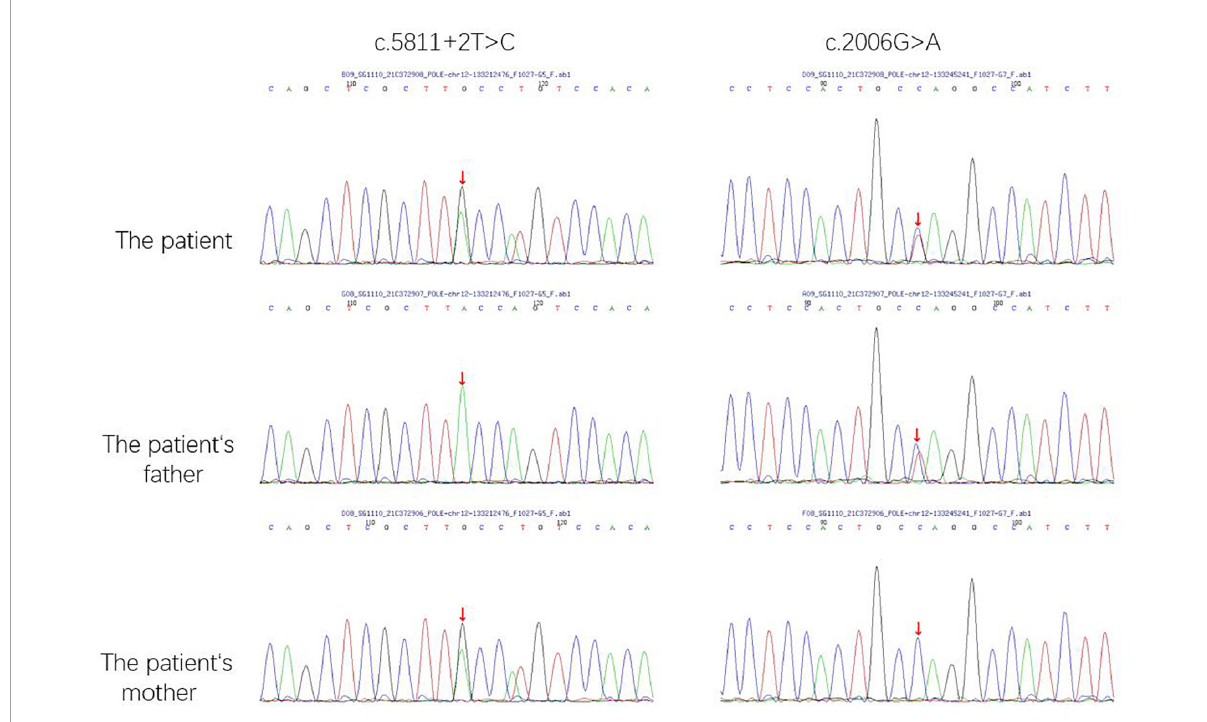
FIGURE3 The POLE gene sequencing map of the patient and his parents. The red arrow indicate the sites of